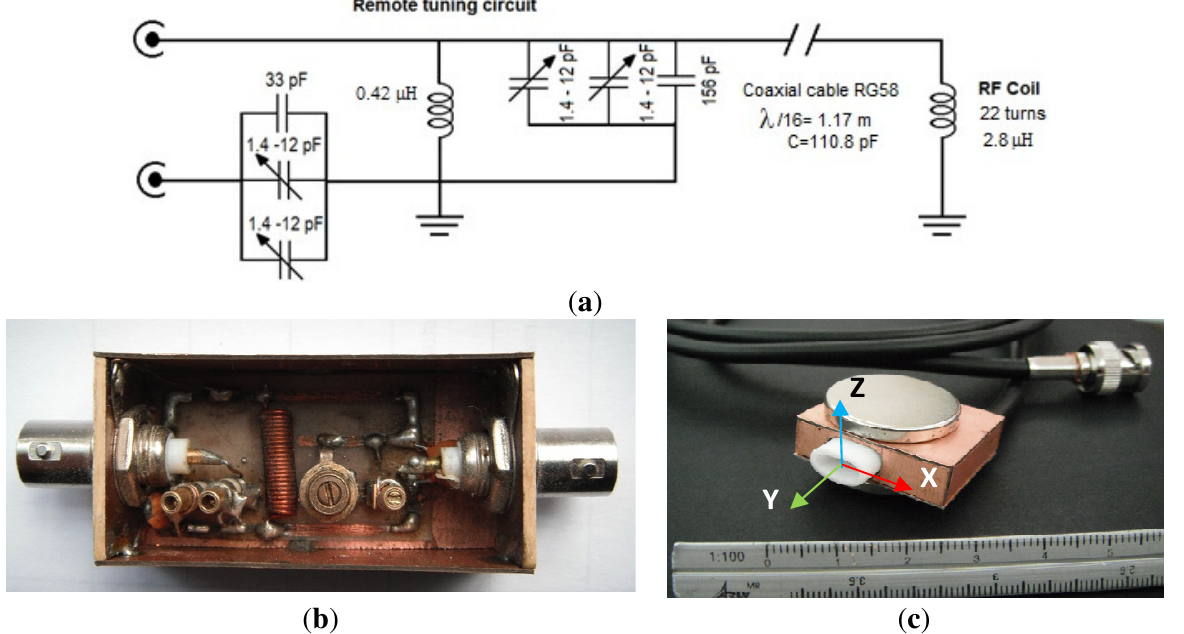
Figure 5. ( a ) Circuit diagram of the sensor 25 mm in width, and 20 mm in